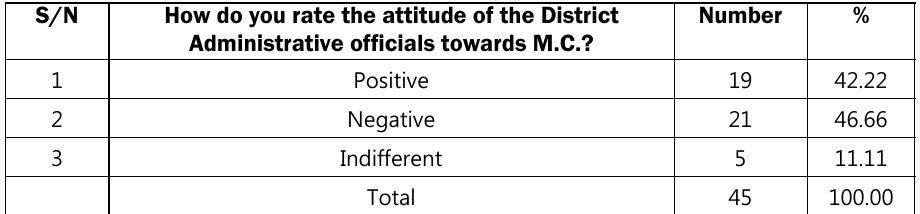
TABLE 11: Perception of selected officials about the attitude of the district administration officials towards municipal council Sirsa S/N How do you rate the attitude of the District